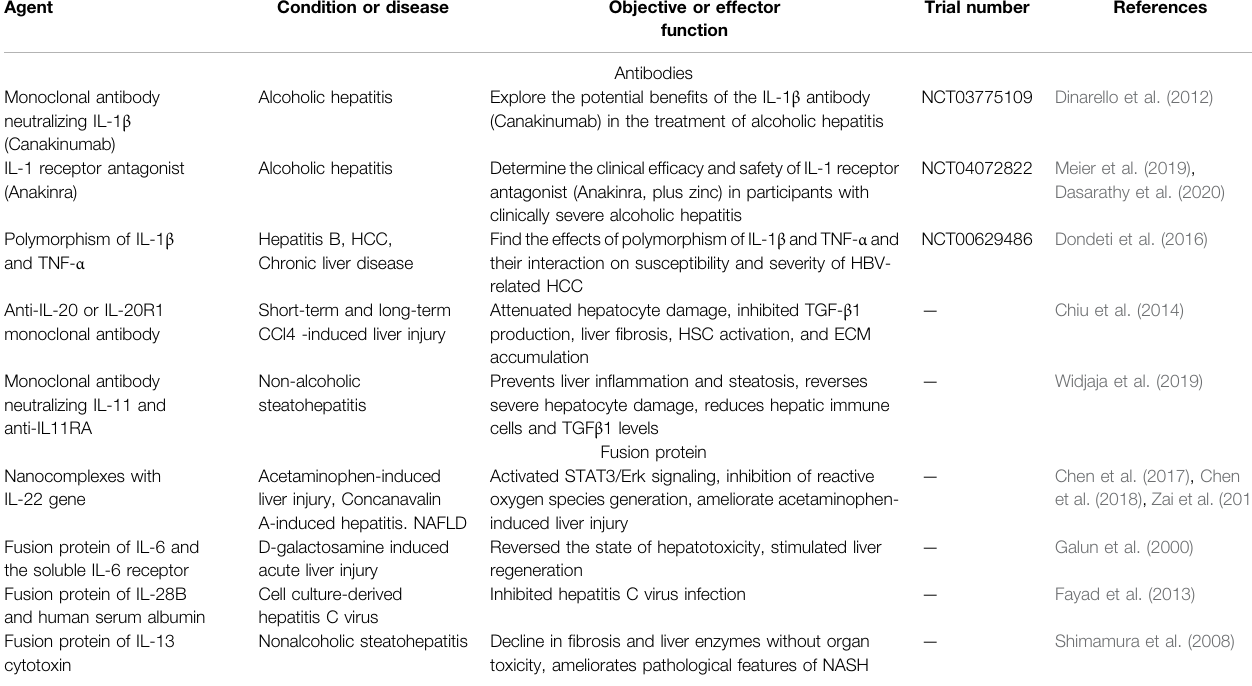
TABLE 1 | Strategies targeting interleukins for liver disease.